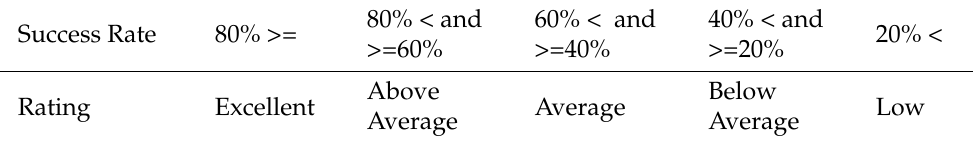
Table 1. Performance evaluation against success